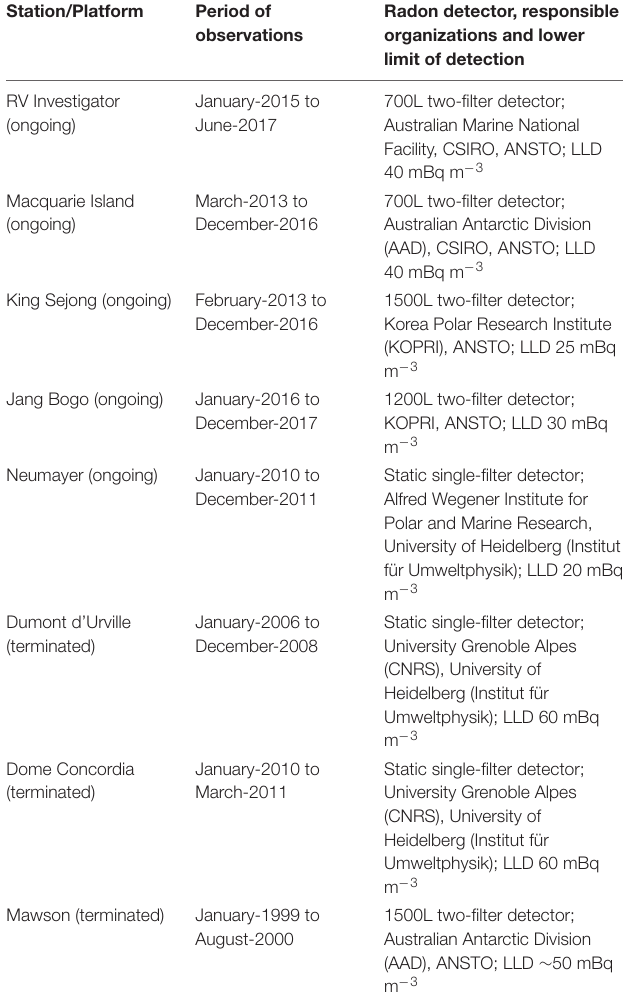
TABLE 1 | Sites, detection method, time periods, and responsible organizations for observations discussed in this study.